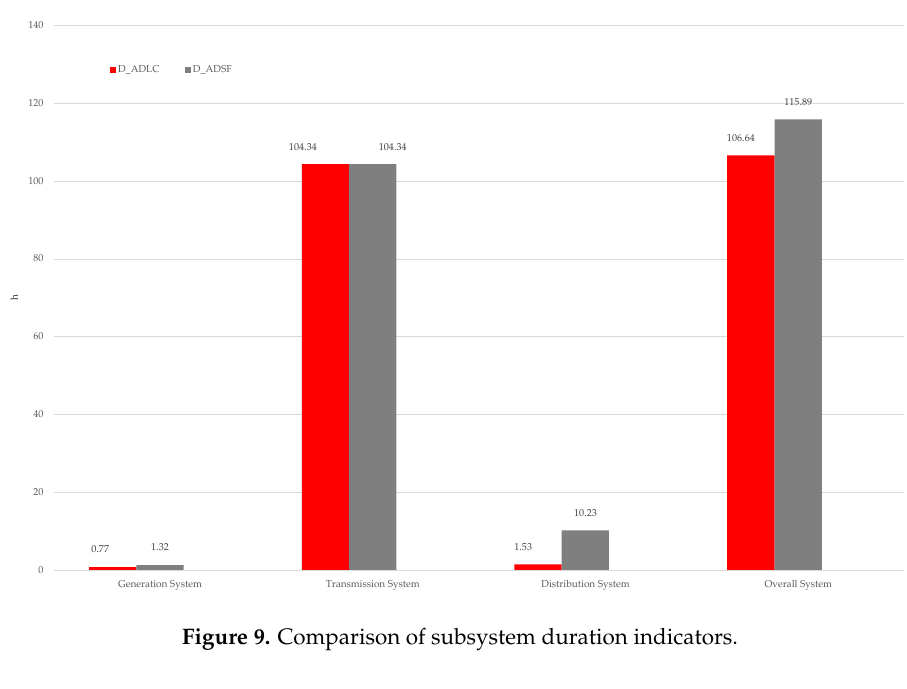
Figure 9. Comparison of subsystem duration indicators.